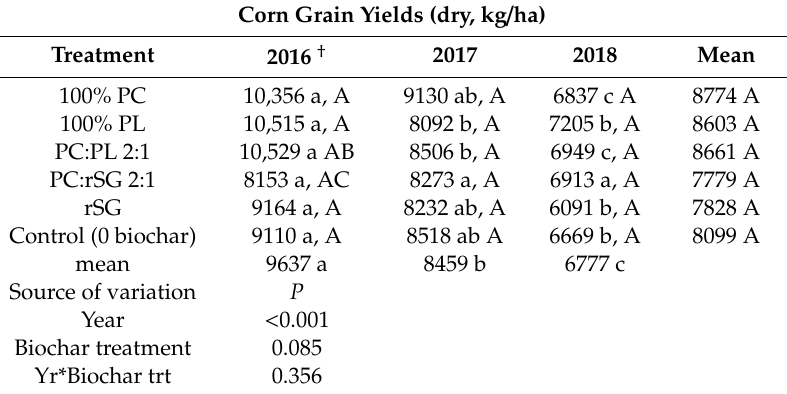
Table 5. Comparison of annual mean corn grain yields (n = 4; PC = pine chip; PL = poultry litter, rSG = raw switchgrass compost).